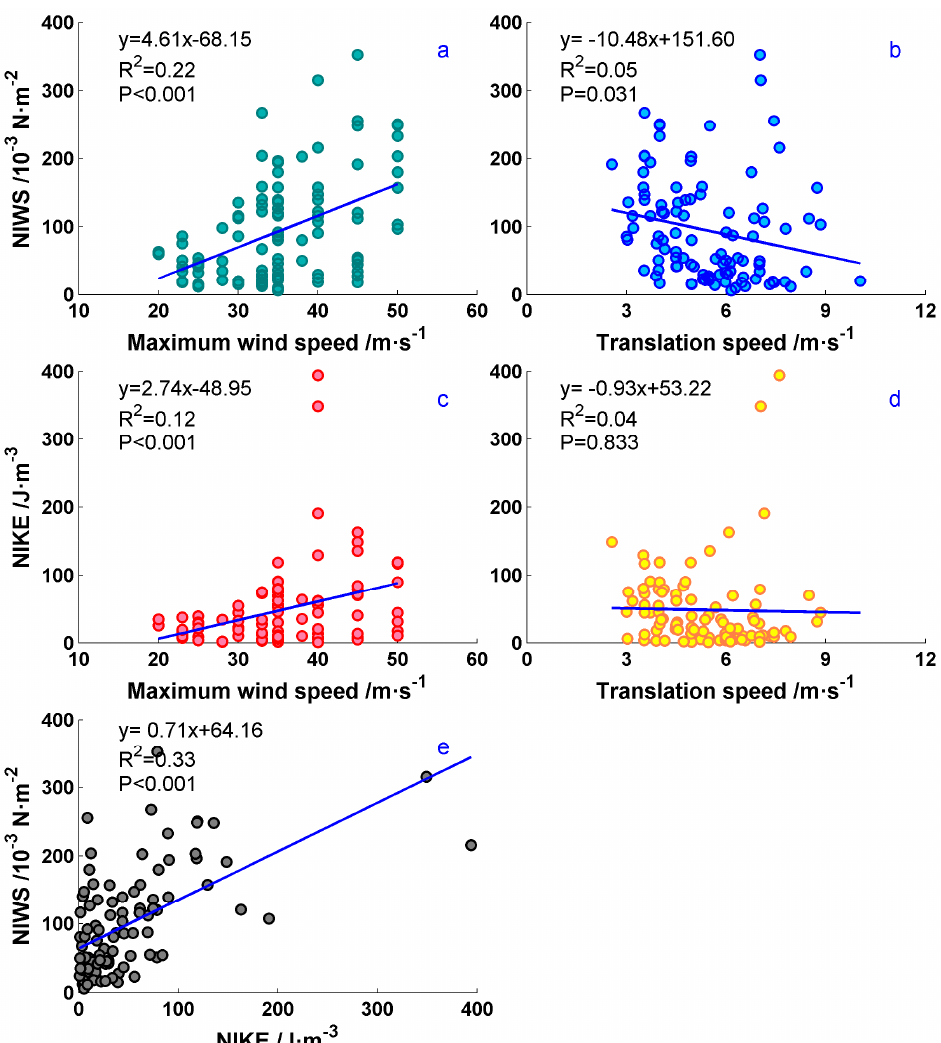
Figure 6. Scatter plots of maximum wind speed (unit in m/s) around the typhoon center and translation speed (unit in m/s) of typhoon versus the corresponding ( a , b ) NIWS (unit in 10 ‐ 3 N/m 2 ) and ( c , d ) NIKE (unit in J/m 3 ) of 12 typhoons. ( e ) Scatter plot of NIKE against the corresponding